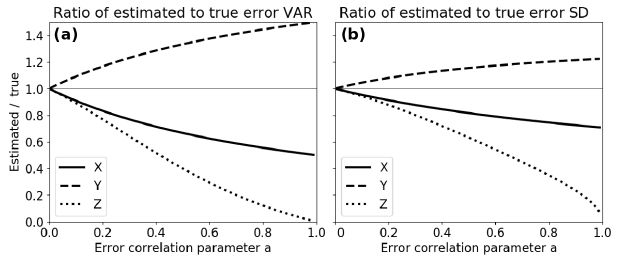
Figure 4. Ratio of estimated (a) error variances to true variances and (b) estimated SD to true SD for the 3CH method for values of error correlation parameter a ranging from 0 to